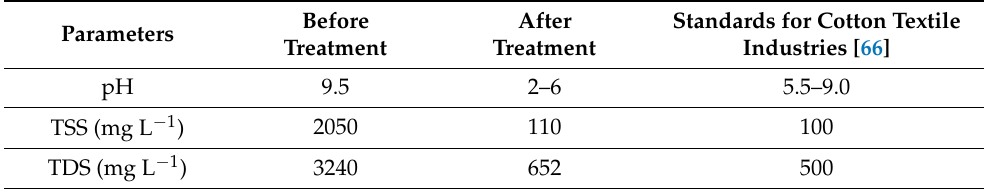
Table 6. Characteristics of the actual wastewater before and after treatment, and standards for the safe disposal of prescribed dye effluents. Parameters